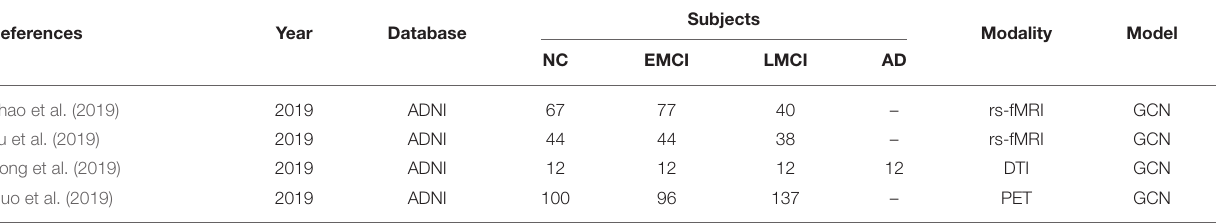
TABLE 3 | Overview of papers using deep learning techniques for MCI prediction.